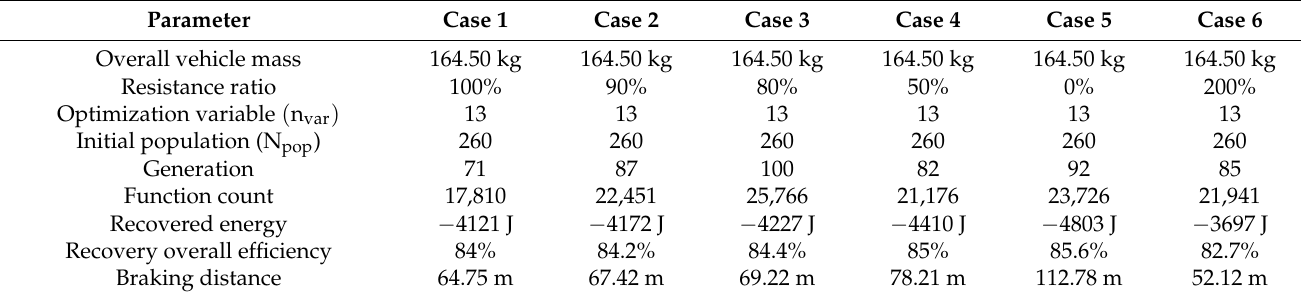
Table 4. Optimization results for resistance force variation.